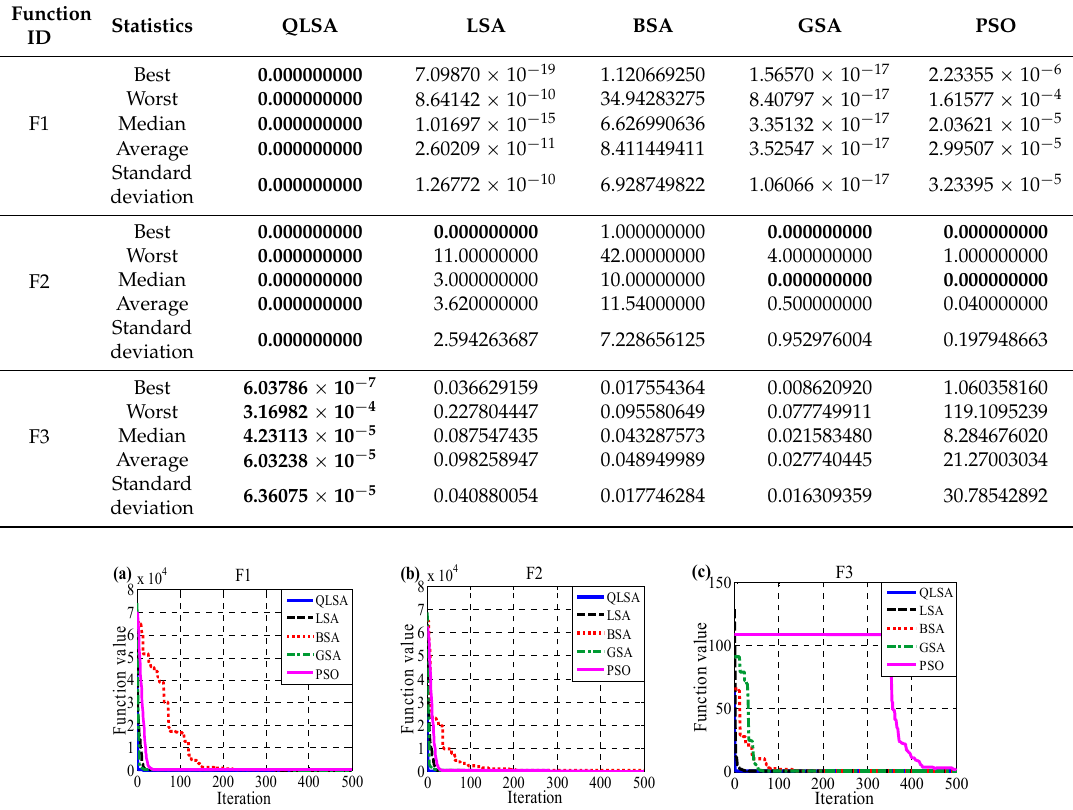
Figure 8. Convergence characteristic curves for QLSA, LSA, BSA, GSA and PSO in: ( a ) F1; ( b ) F2; ( c ) F3. Backtracking search algorithm: BSA; gravitational search algorithm: GSA; particle swarm